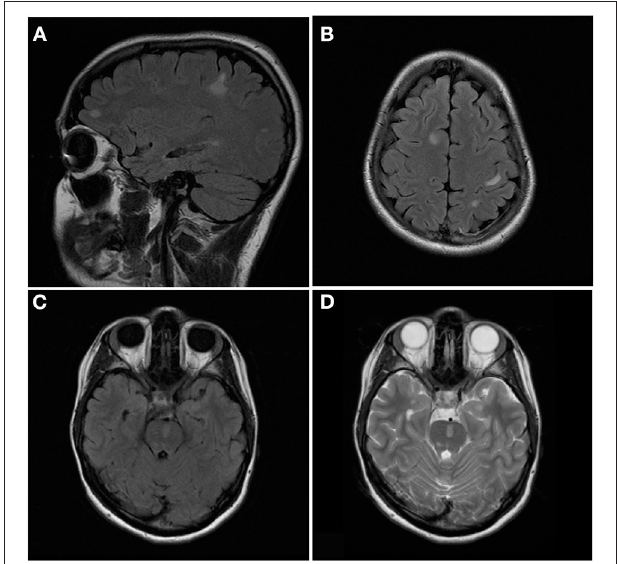
FIGURE 6 | Sagittal FLAIR (A) , axial FLAIR (B,C) , and axial T2 (D) images of the brain from the same patient at the time of disease presentation. (A,B) Multiple FLAIR hyperintense lesions involve the juxtacortical and subcortical white matter of both cerebral hemispheres. (C,D) Additional T2/FLAIR hyperintense lesions involves the juxtacortical white matter of the left temporal lobe and